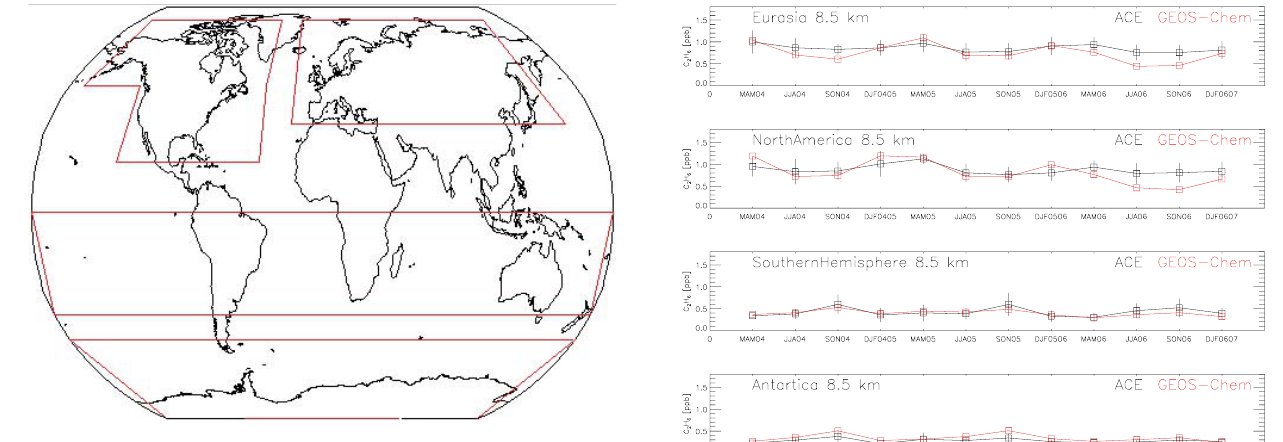
Fig. 11. Geographical regions selected for detailed comparison of ACE and GEOS-Chem data.